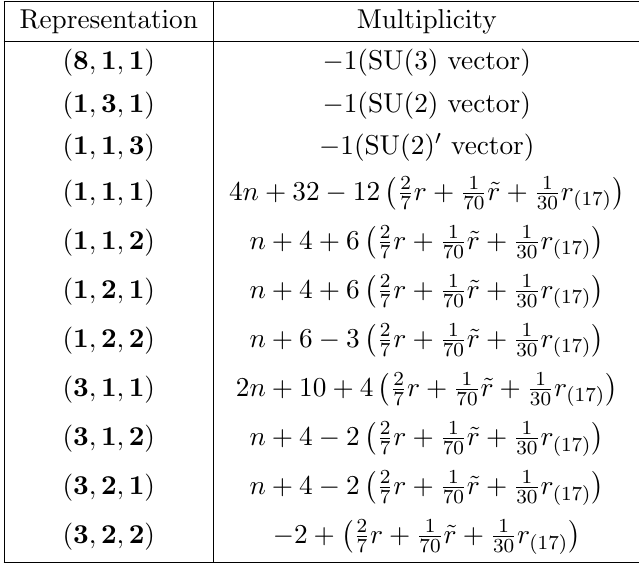
Table 16 . The spectrum for the con(cid:12)guration No.12. H = SU(2) (cid:2) U(1) 3 . and U(1) , respectively, we obtain the result as shown in table 16, which coincides (17)